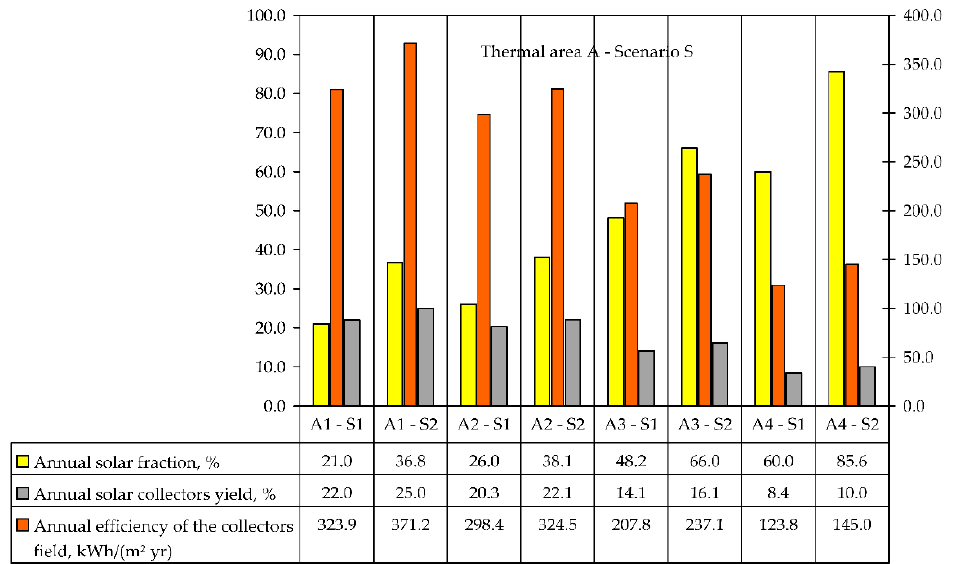
Figure 7. Performance indicators of the solar system. Comparative graphs for A 1 –A 4 .